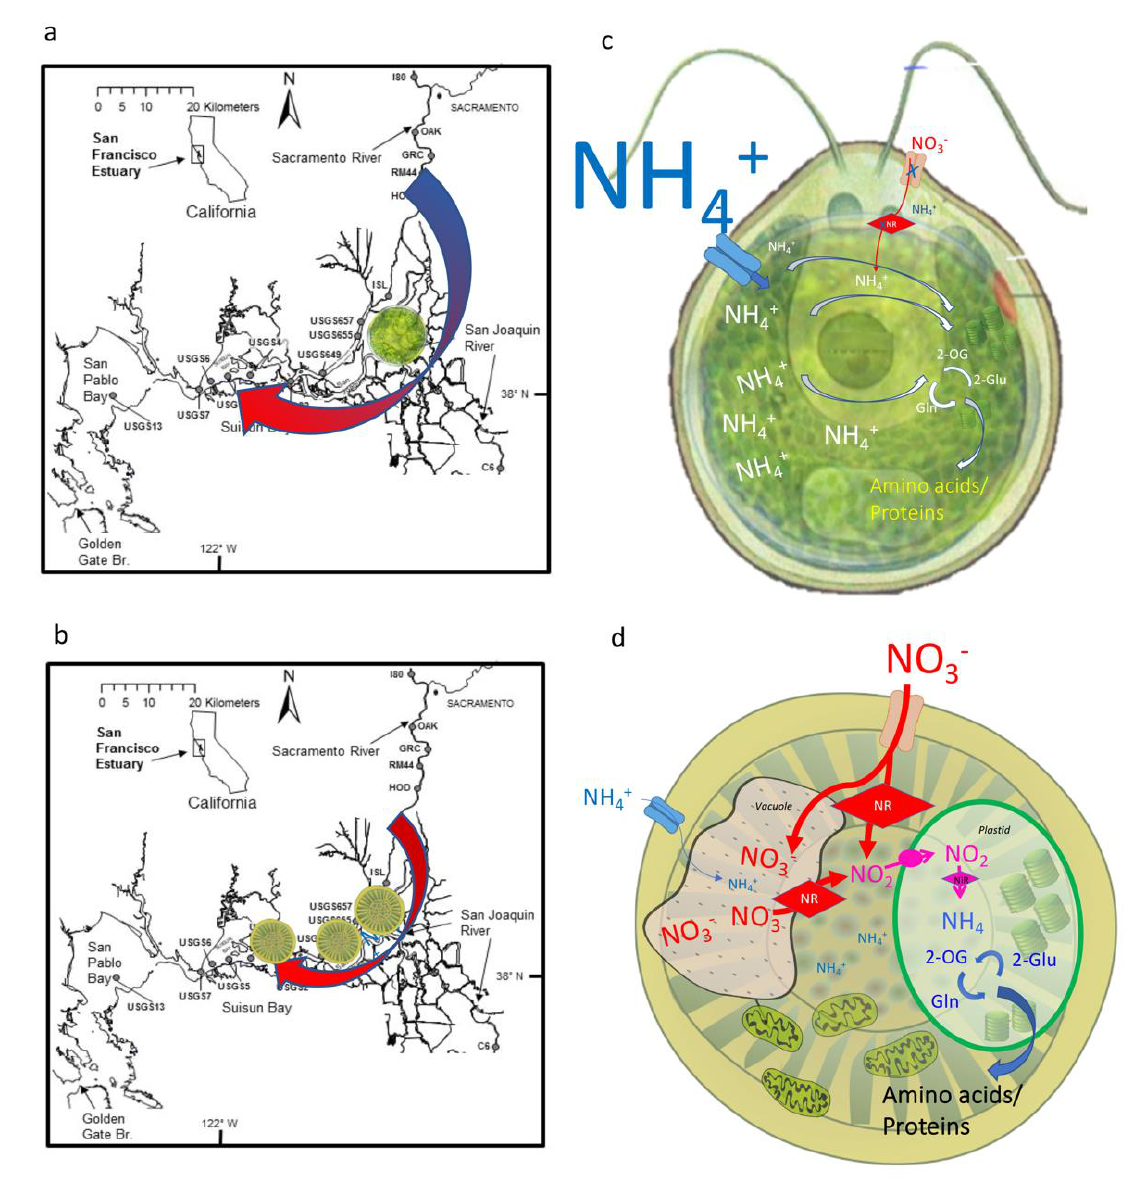
Figure 11. Comparison of the two low-flow years, 2015 (panels a , b ) and 2021 (panels c , d ), pre- and post-WWTP upgrade. In 2015, there was very high NH 4+ in the effluent (blue end of arrow in panel a ) and nitrification (transition to red in arrow in panel a ) occurred by station 8. A peak in chlorophyll a developed and was dominated by chlorophytes which were readily able to access the NH 4+ (panel b ) but which could not sustain growth. In 2021, the effluent was in the form of NO 3 − , which remained available through the transect (red arrow in panel c ) and was accessible to diatoms (panel d ) which were then able to sustain growth through the remainder of the transect. See text for